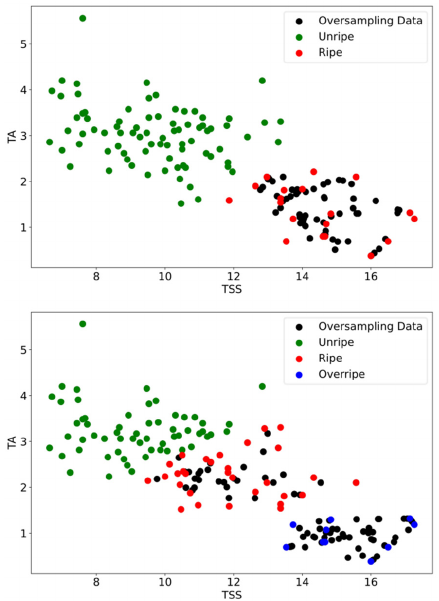
Table 4. Comparison of the original data and oversampling data for training ML classifiers.